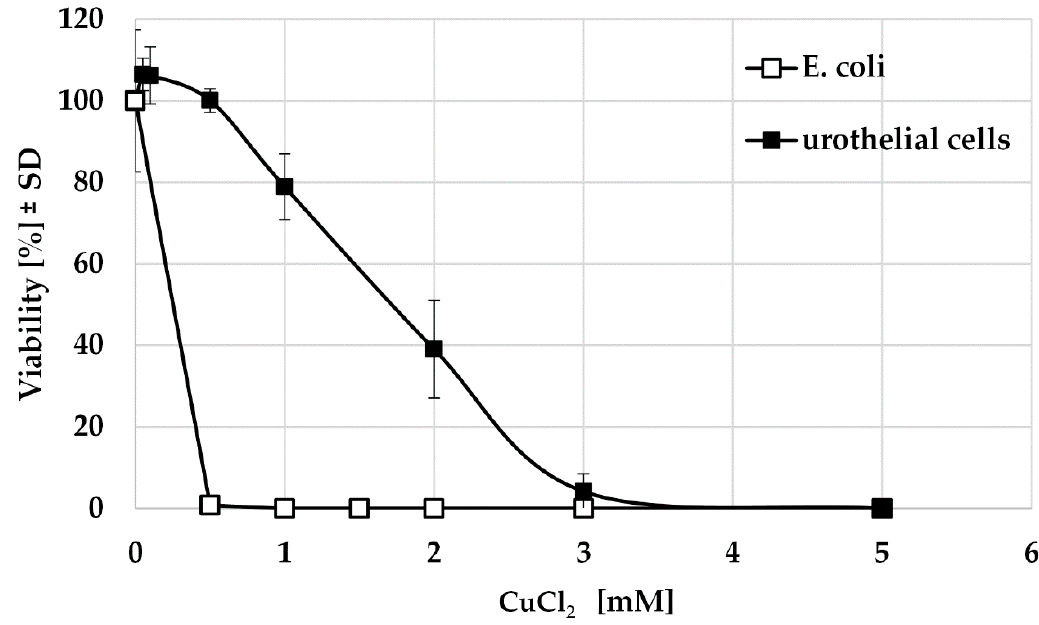
Figure 3. Viability of E.coli and urothelial cells HUC-1 after 24 h stimulation with CuCl 2 ( n = 3).